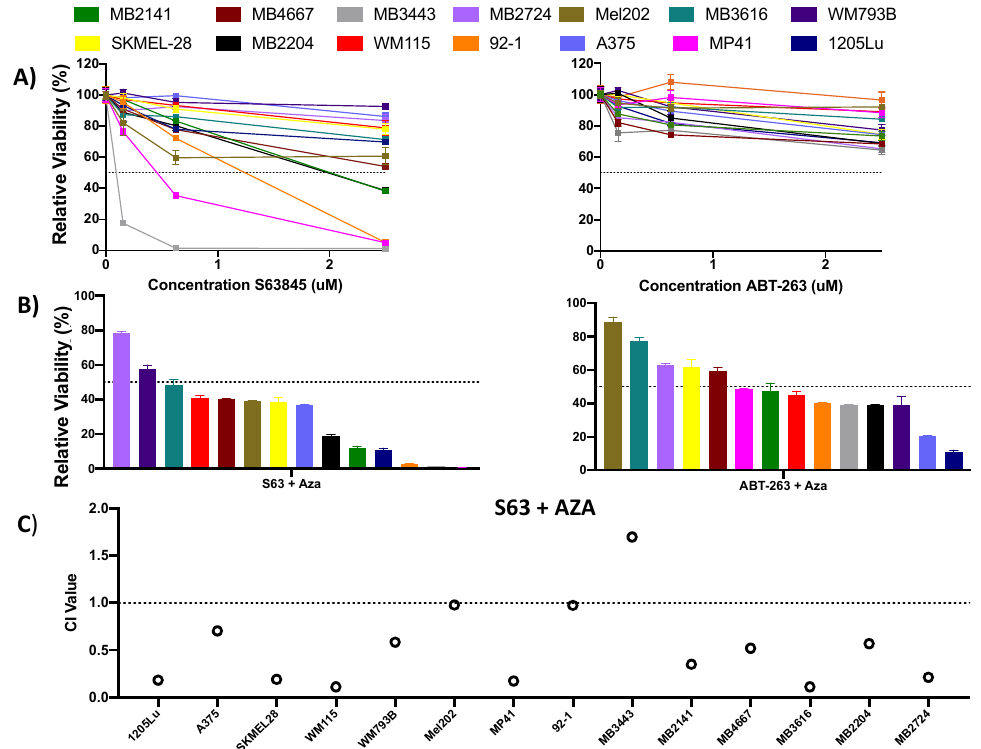
Figure 3. Combination treatment with S63845 + AZA is effective in synergistically reducing melanoma cell viability. ( A ) Single agent S63845 and ABT-263 dosed at a concentrations of 0.156–2.5 uM in human melanoma cell lines. ( B ) Combination treatment with S63845 + AZA, and ABT-263 + AZA dosed at 2.5 uM each in human melanoma cell lines. ( A , B ) All cells were treated for 48 h. Dotted line indicates 50% viability. Y axis indicates viability relative to DMSO control, set to 100%. X axis indicates drug treatment. Error bars represent +/ − SEM. ( C ) CI values for S63845 + AZA treatment. CI <0.9 indicates synergy, 0.9–1 indicates additivity, >1 indicates antagonism. CI values are calculated at the 2.5 uM dose using CompuSyn (version 1) software. Black dotted line indicates CI value of 1. Y axis indicates CI value, X axis indicates cell line and treatment.